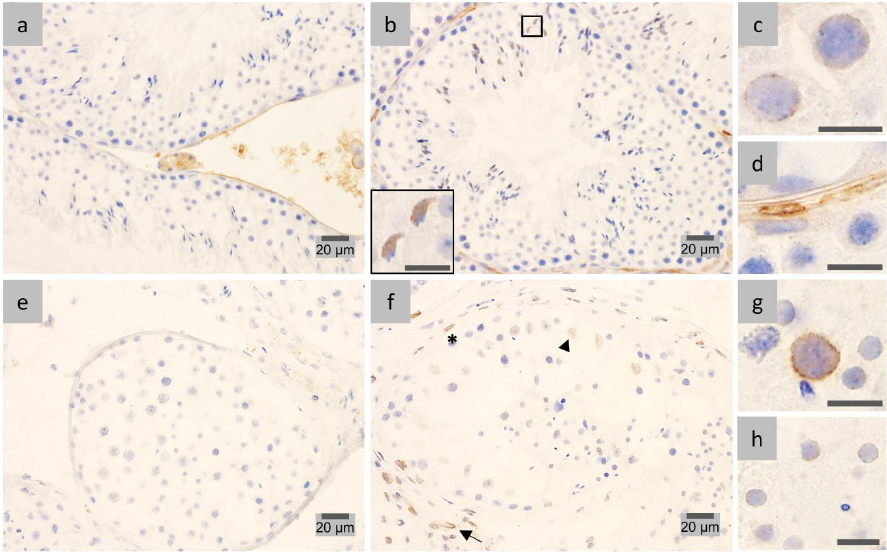
Figure 5. Immunohistochemical localization of lamin A/C in mouse ( a – d ) and human ( e – h ) testis sections fixed in diluted Bouin’s solution. Positive immunostaining appears in brown color and nucleus counterstaining with hematoxylin. ( a , e ) Negative controls revealed weak lamin A/C staining in the cytoplasm of interstitial tissue. ( b ) Mouse seminiferous tubule stained for lamin A/C shows localization most evident in the acrosome of elongated mature spermatids (ROI, scale bar: 8 µ m), as well as ( c ) in the NE of pachytene spermatocytes and ( d ) peritubular cells (scale bars: 8 µ m). ( f ) In human testis, lamin A/C staining is observed in the NE of peritubular (asterisk), Leydig (arrow)